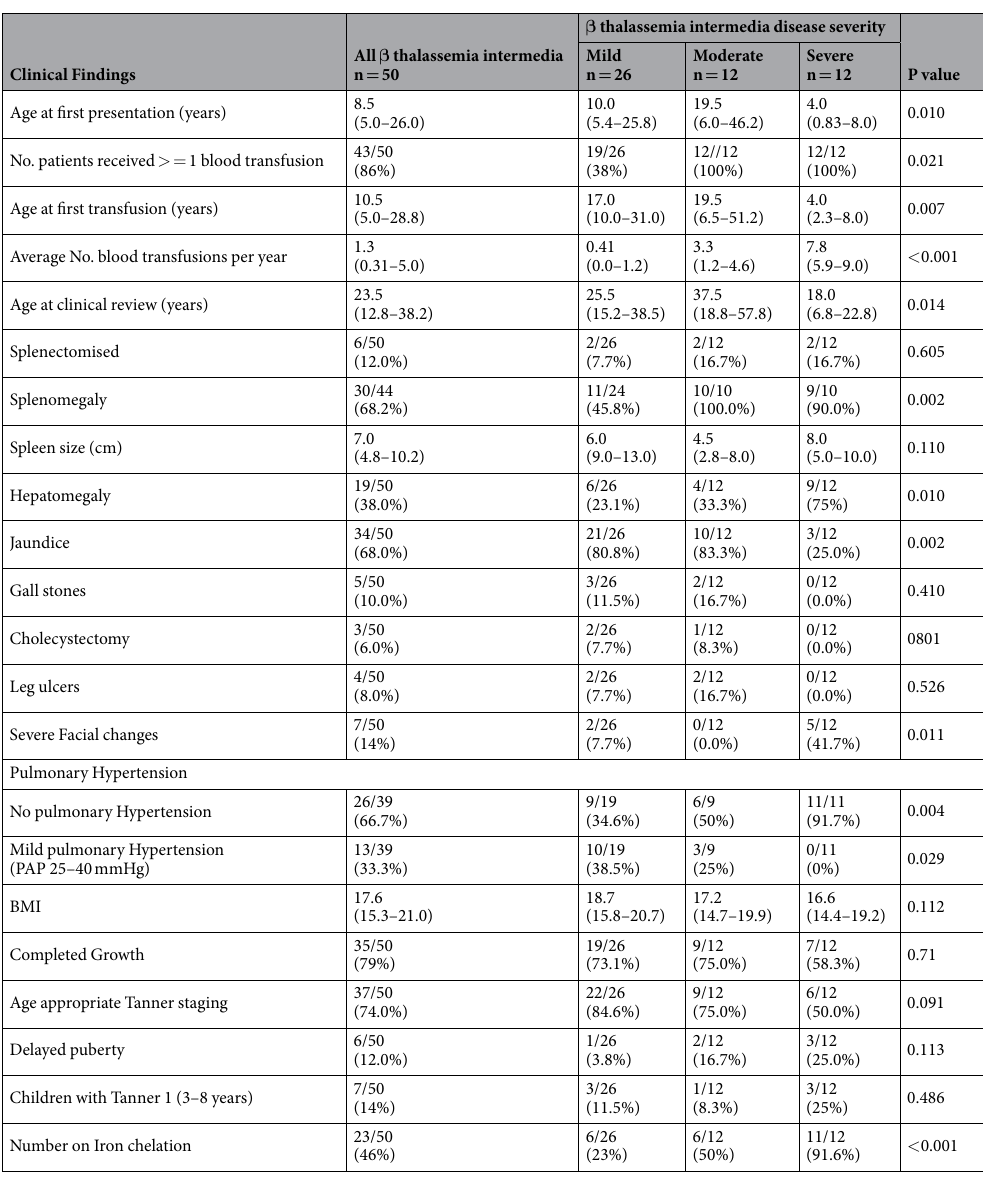
Table 1. Clinical Findings of β thalassemia intermedia cohort in Sri Lanka. Data are median (IQR) or number